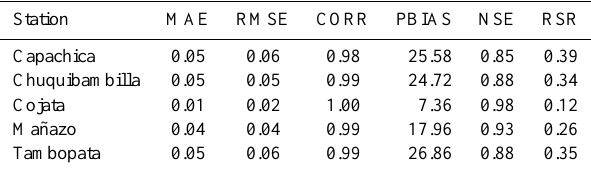
Table 5. Goodness of fit for exceedance probability curves on the wet season (November–March) from 1999 to 2006.